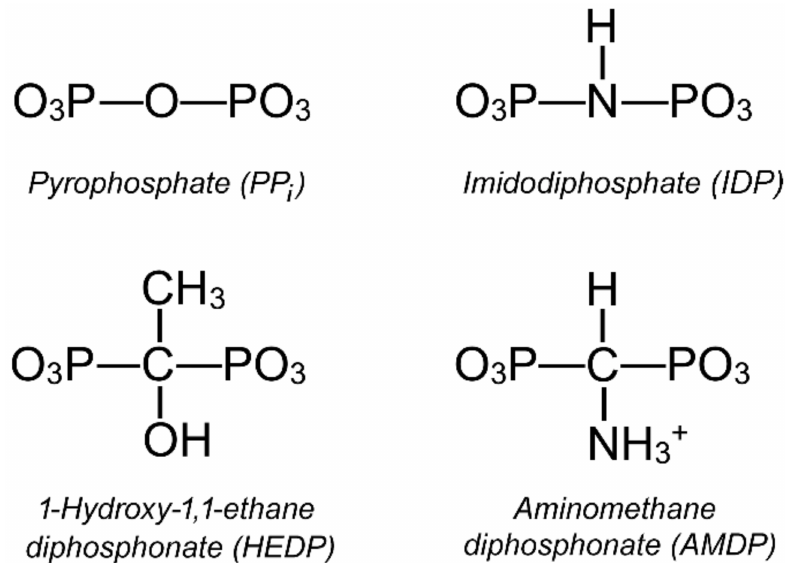
Figure 2. Structures of the PP i analogs. The bridging groups of IDP and AMDP are shown in the ionic forms that prevail at pH 7.2 [26,27]. The phosphate residues are predominantly deprotonated in the magnesium complexes of all